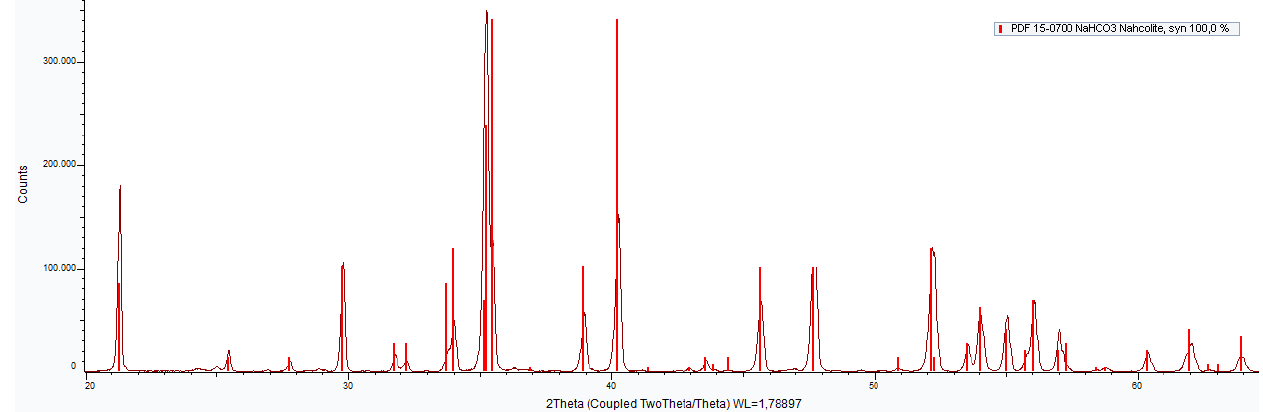
Figure B3. XRD quantitative analysis for crystals produced at 30 °C.